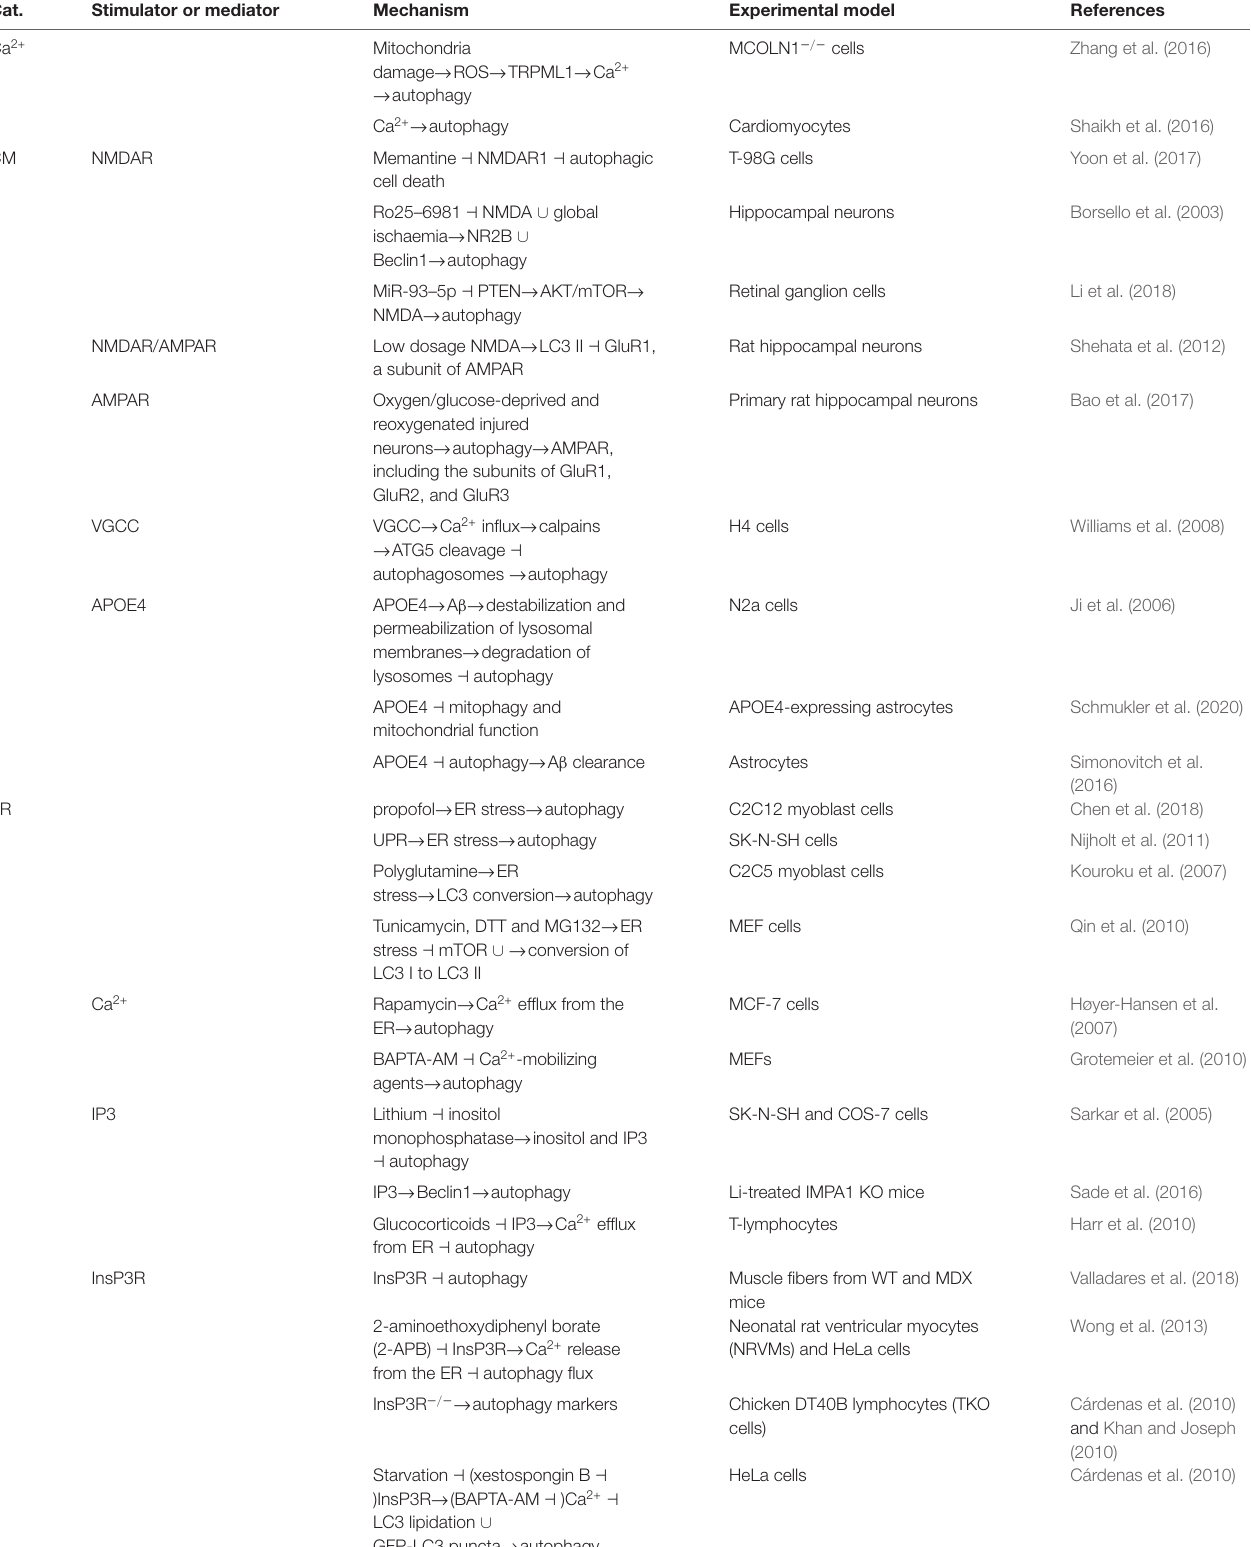
TABLE 5 | Ca 2+ disrupts the effects of autophagy on clearing aggregated proteins.